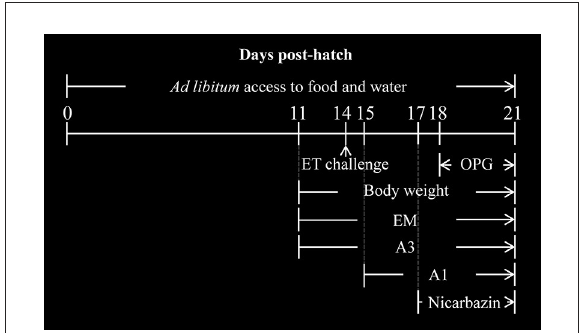
FIGURE1 Diagrammatic representation of the in vivo studies. The days post hatch of the ET challenge (arrow), drug administration, and body weight measurements are indicated. A3 and A1 represent the EM treatment 3 days before and 1 day after ET infection, respectively. EM, extract and essential oil mixture (non-toxic concentrations of Punica granatum L., Plantago asiatica